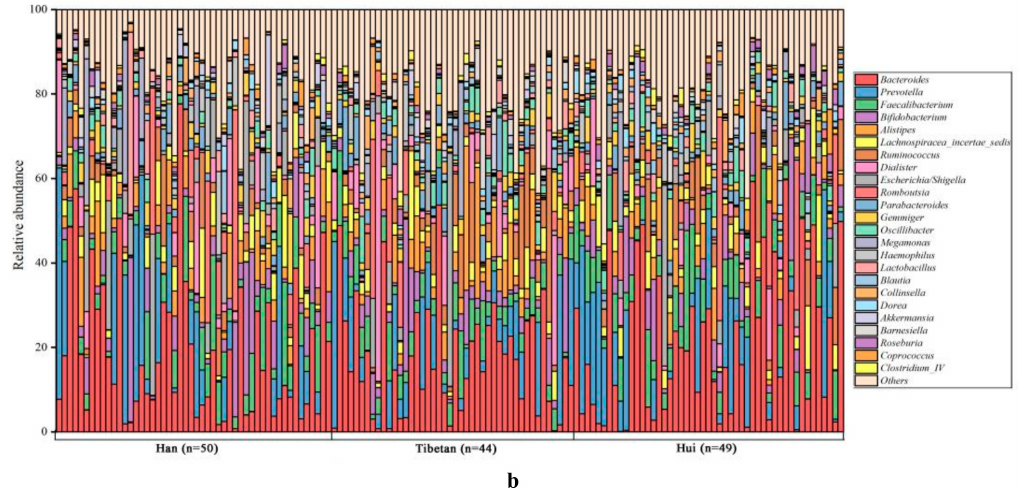
Figure 1. Relative abundance of bacterial phyla ( a ) and genera ( b ) in the fecal microbiota of all participants.